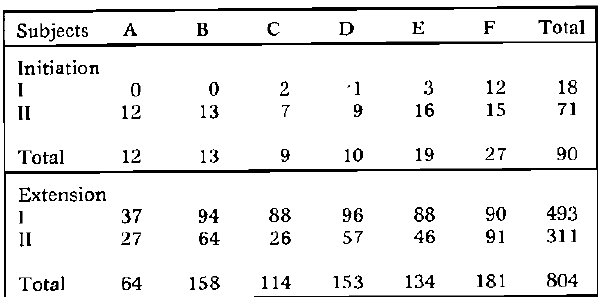
Table 6: Topic initiation & extension for all subjects